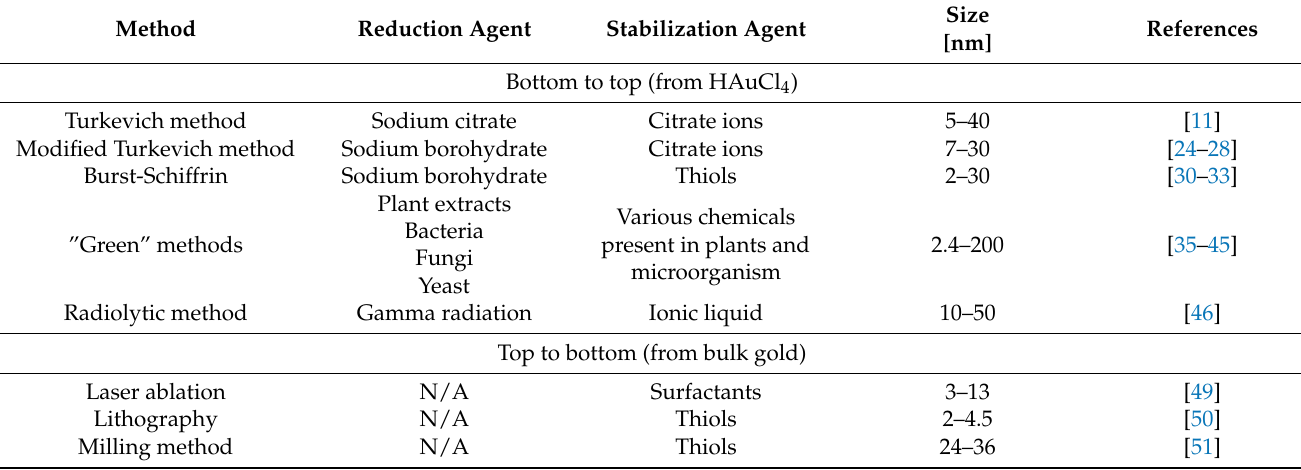
Table 1. Most common methods used for the preparation of